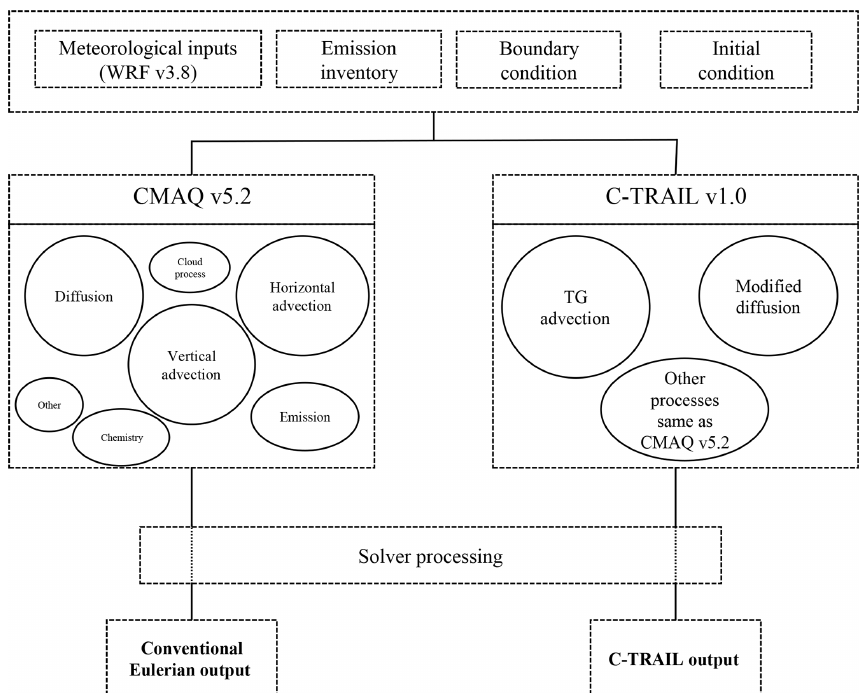
Figure 1. Schematic of conventional CMAQ versus